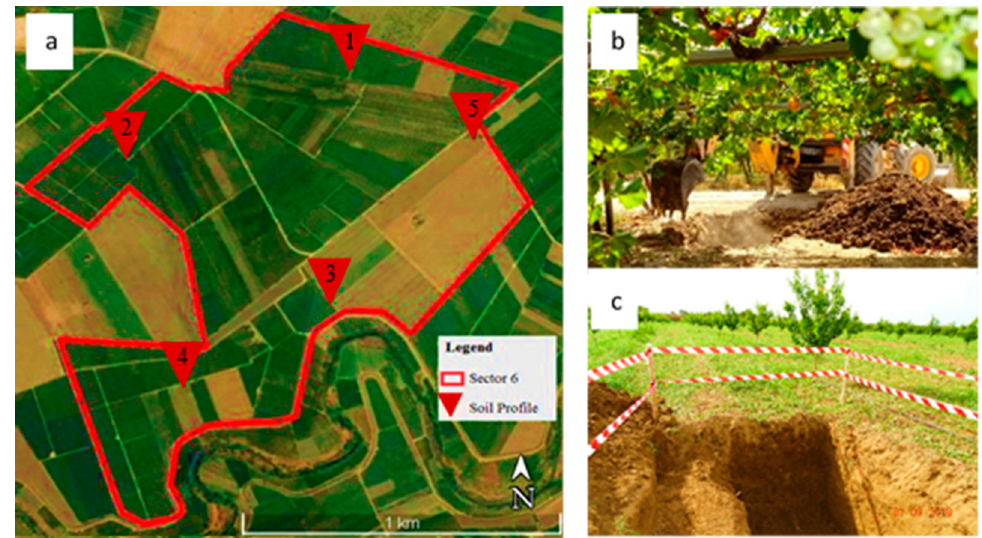
Figure 4. ( a ) Soil profile distribution; ( b ) Digging of a soil pit; ( c ) details of the soil profile vegetation context.